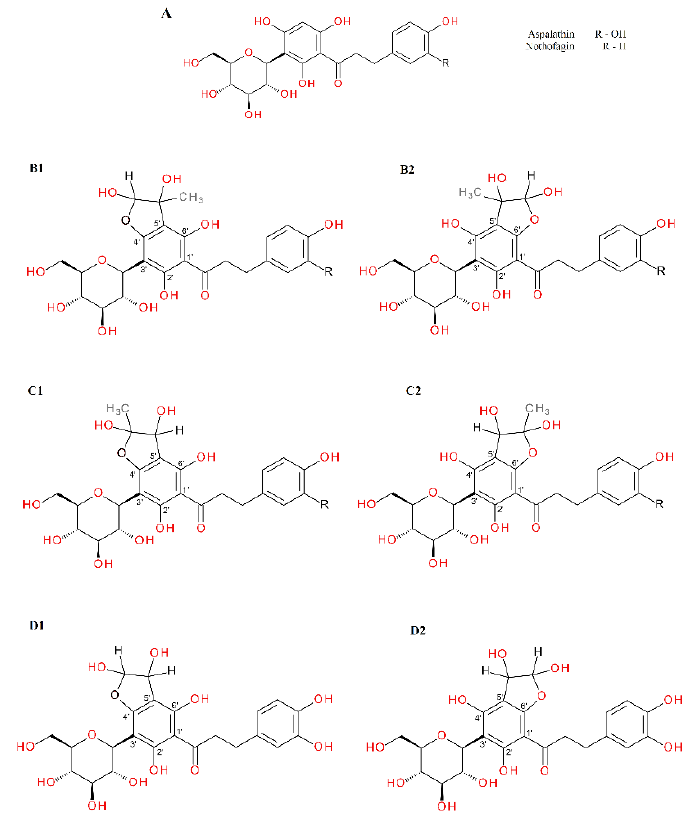
Figure 8. Proposals for chemical structures of adducts formed in the reaction of aspalathin/nothofagin with methylglyoxal/glyoxal after 1 h of incubation in pH 7.4 phosphate buffer solution at 37 °C; ( A ), aspalathin/nothofagin; ( B1 , B2 ), hemiacetal forms of mono-MGO-aspalathin/nothofagin; ( C1 , C2 ), hemiketal forms of mono-MGO-aspalathin/nothofagin; ( D1 , D2 ), mono-GO-aspalathin isomers. Other isomers are also possible.